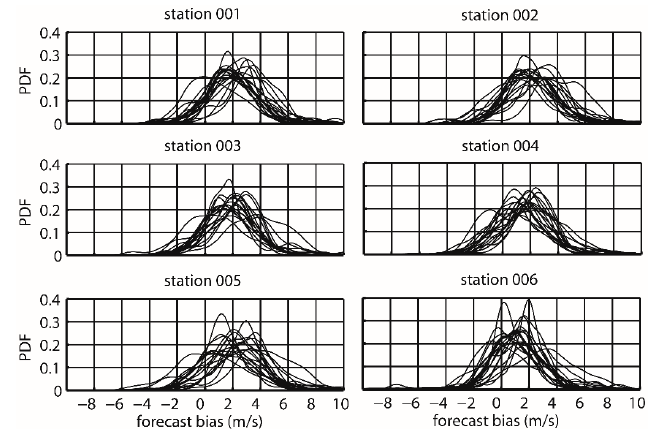
Figure 4. Prediction bias distributions of 18 weather types at the six wind farms.